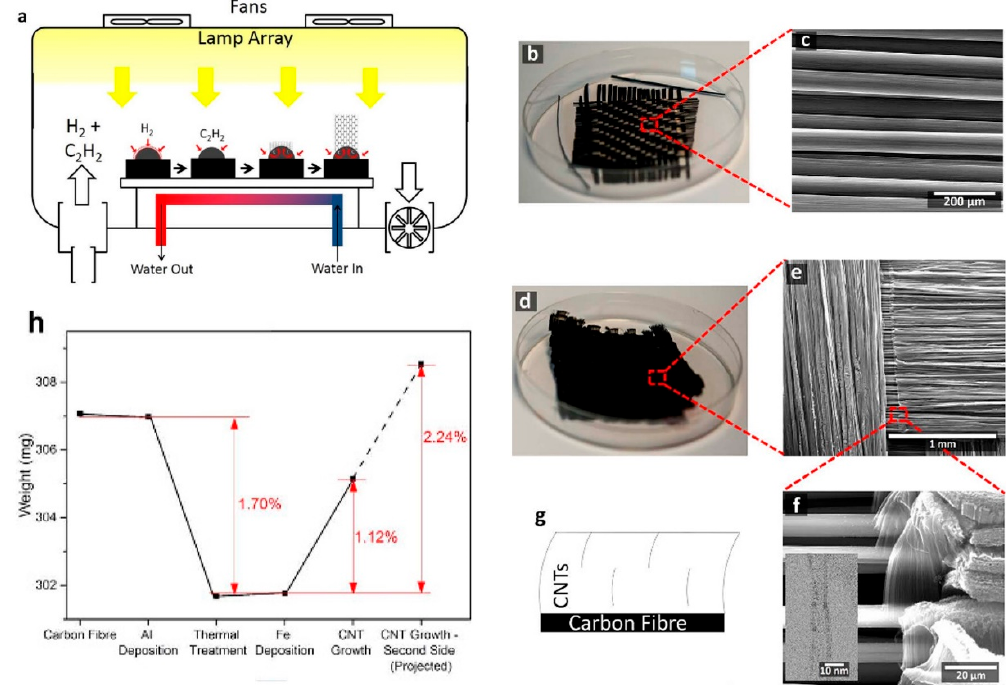
Figure 30. ( a ) Schematic representation of PTCVD for the growth of VACNT; ( b ) Digital image of as-received CF cloth with ( c ) SEM micrograph of aligned CF; ( d ) Digital image of VACNT/CF cloth composite material with ( e , f ) different magnification of SEM images where ( f ) presents an insert of STEM micrograph of the examined multi-wall (MW)CNT; ( g , h ) Figurative representation of the weight change after each consecutive step in the twin-side VACNT/CF cloth composite growth. Modified after [4].